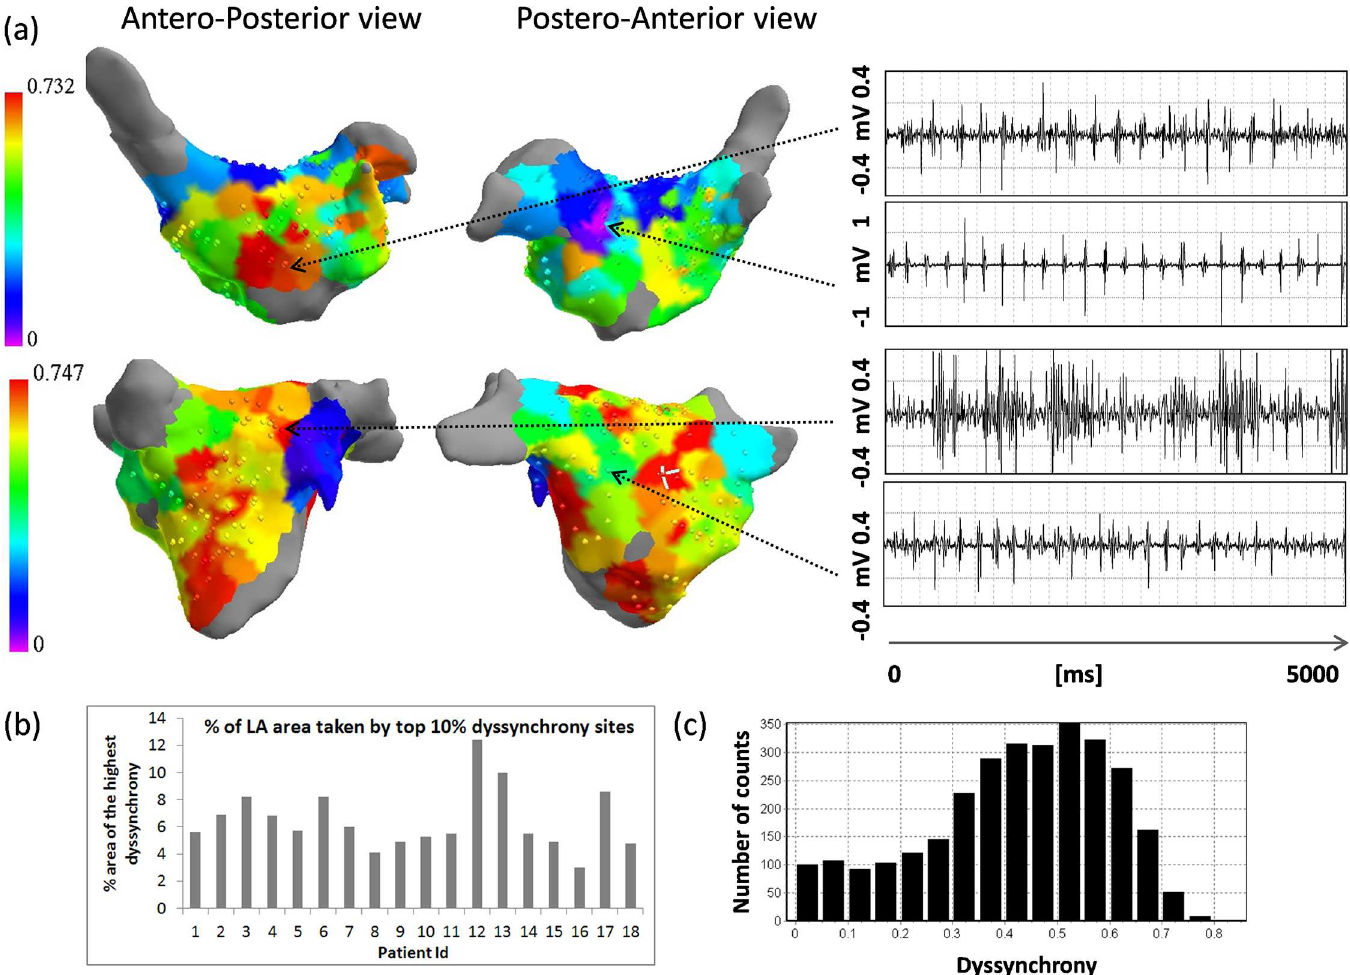
Fig 4. Example dyssynchrony maps with electrograms from areas of high and low dyssynchrony. (a) Dyssynchrony maps. Dyssynchrony level is color-coded with purple corresponding with the lack of dyssynchrony (regular local pattern of activity) and red corresponding to 90% of the maximum value of dyssynchrony in given map. Red areas became the targets of ablation. (b) Percentage of the assignedarea taken by top 10% of dyssynchrony per patient. Distributionof all dyssynchrony values at all collectedall data points (c) (bin size of